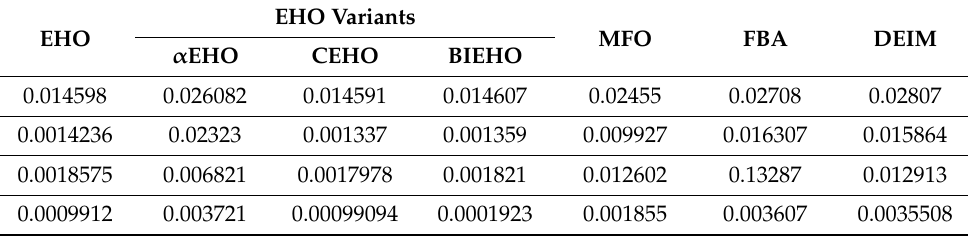
Table 8. Comparison between EHO algorithms, MFO, FBA, and DEIM for three-diode solar